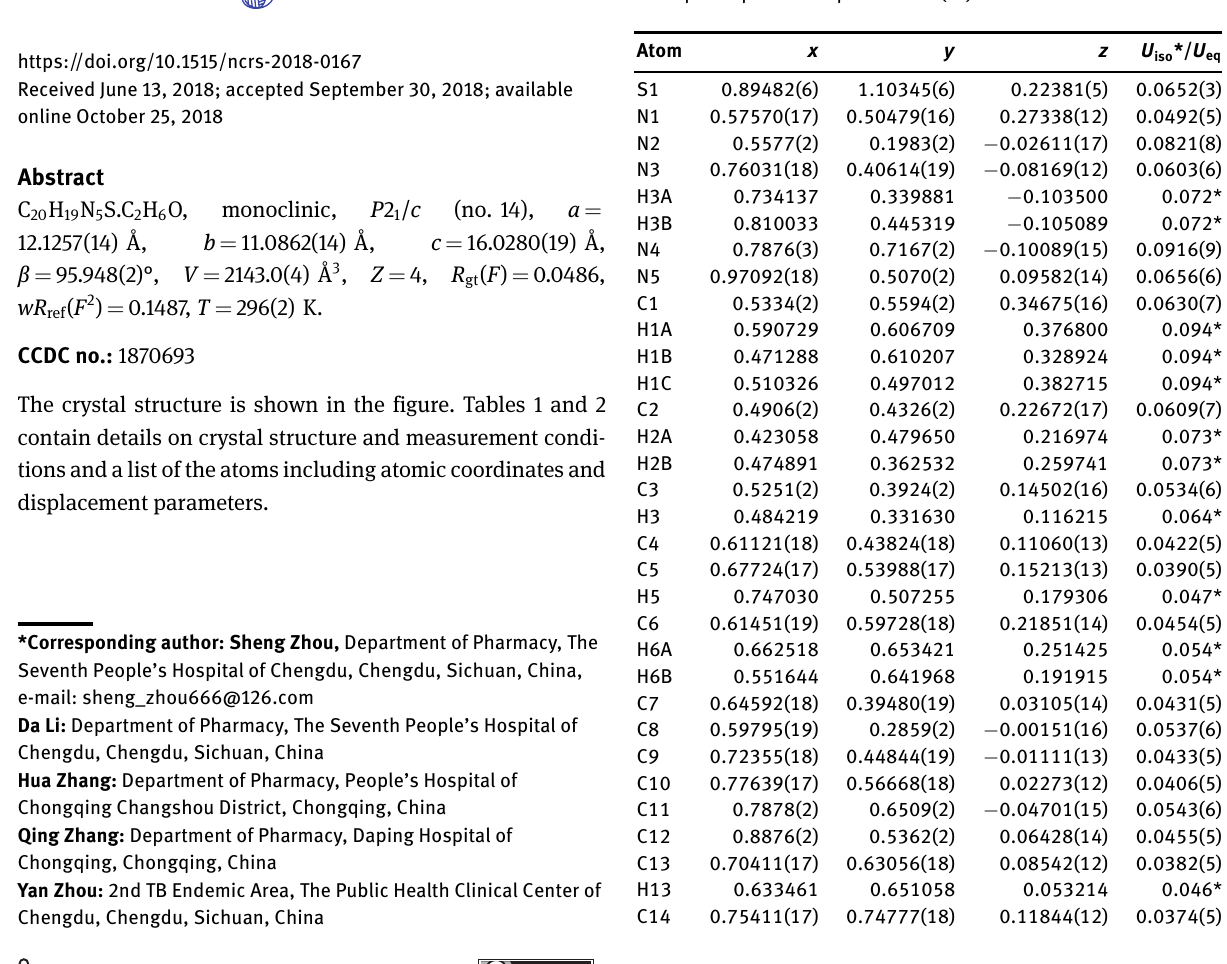
Table 2: Fractional atomic coordinates and isotropic or equivalent isotropic displacement parameters (Å 2